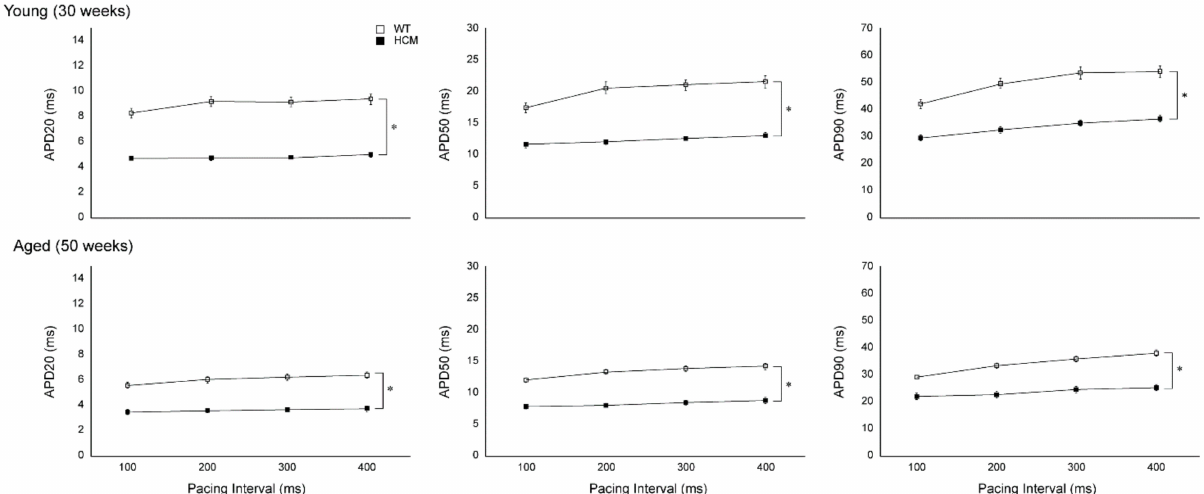
Figure 1. Action potential durations (APD) at 20% (APD20), 50% (APD50), and 90% (APD90) repolarization are reduced in both young and aged hypertrophic cardiomyopathy (HCM) atria. Young HCM mice atria demonstrated reduced APD20, APD50, and APD90 compared to control mice across all pacing cycle lengths tested. Similarly, aged HCM mice also showed reduced APD20, APD50, and APD90 compared to controls across all pacing cycle lengths tested. * p <